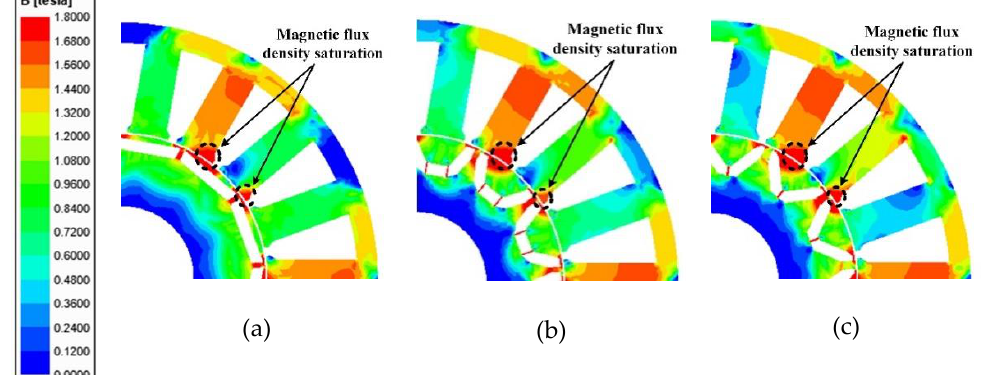
Figure 4. Magnetic field distribution at 1350 rpm. ( a ) Bar-type IPMSM; ( b ) U-type IPMSM; ( c ) V-type IPMSM. Table 2. Comparison of torque ripple and cogging torque at 1350 rpm.